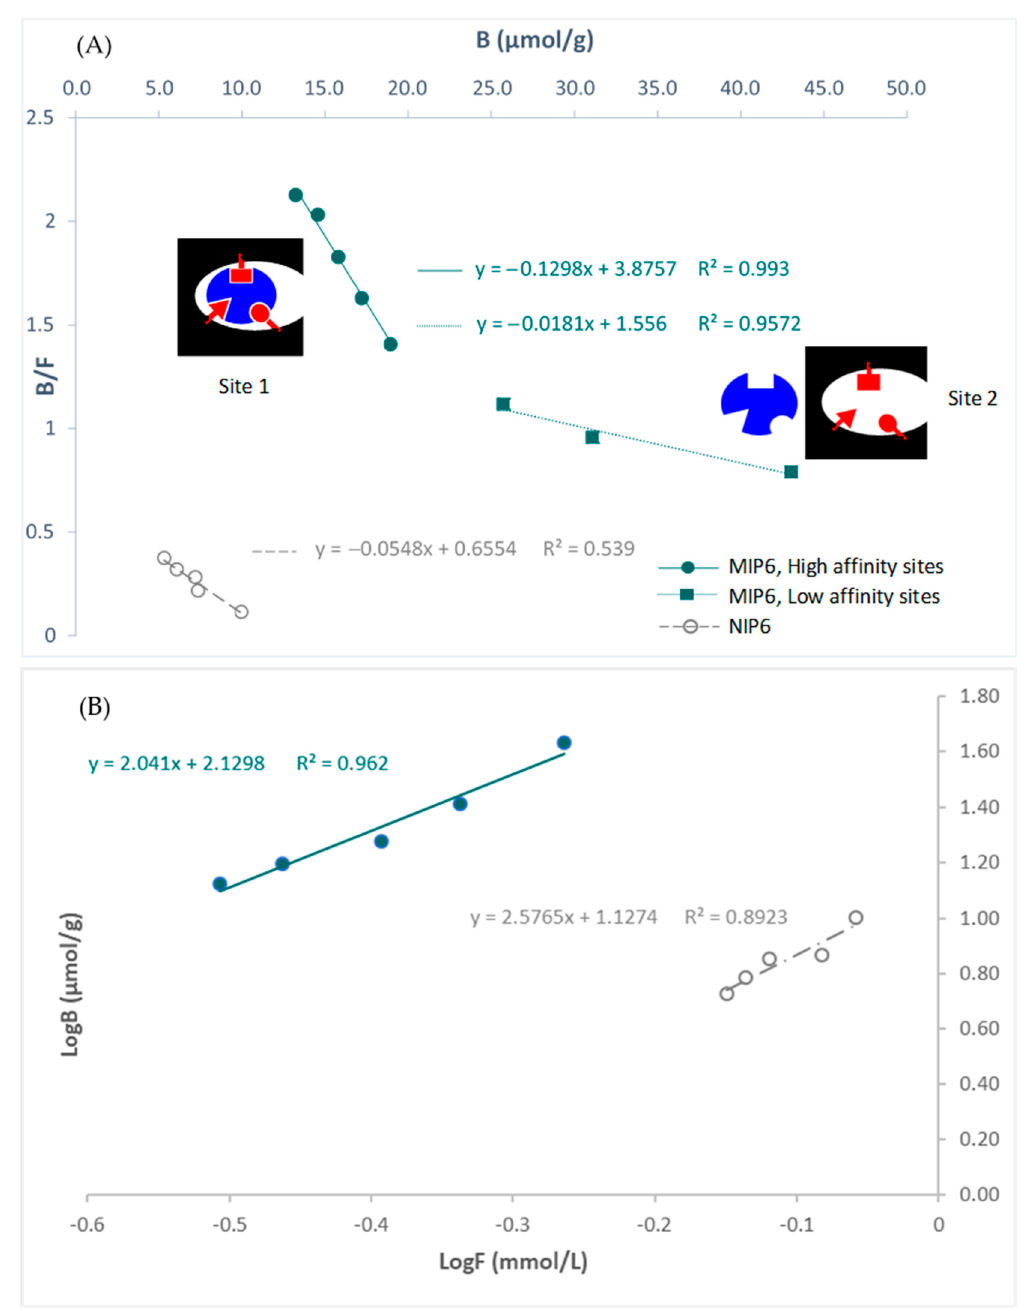
Figure 4. ( A ) Scatchard plots for MIP6 and NIP6, and ( B ) affinity distributions plotted in log format. Site 1: high-a ffi nity site. Site 2: low-a ffi nity site.